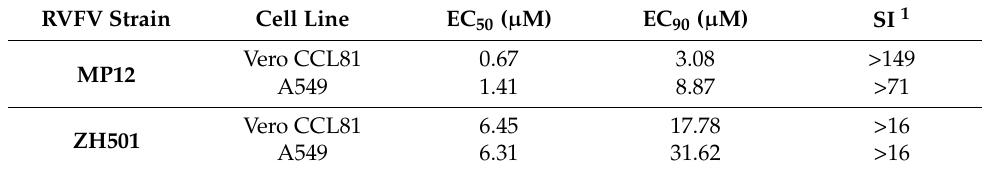
Figure 1. In vitro dose-response of Tilorone against RVFV. Vero CCL81 cells ( A , C ) or A549 cells ( B , D ) were infected with RVFV MP12 ( A , B ) or RVFV ZH501 ( C , D ) at an MOI of 0.1 for 1 h. Cell culture media with serial 10-fold dilutions of Tilorone was added at 1 h post infection (HPI). Reduction in virus yield was determined by plaque assay in cell culture supernatant collected at 24 HPI. Data is representative of two individual experiments, each with three biological replicates. Table 2. In vitro antiviral efficacy of Tilorone against RVFV.